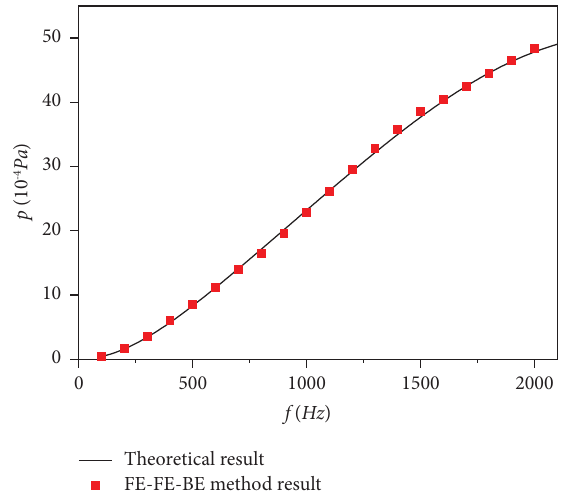
Figure 5: Results of the acoustic pressure (10 − 4 Pa).